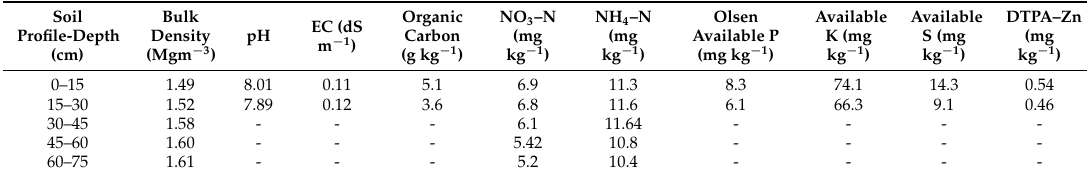
Table 1. Physico-chemical characteristics of the soil measured at commencement of the field experiment in 1998.